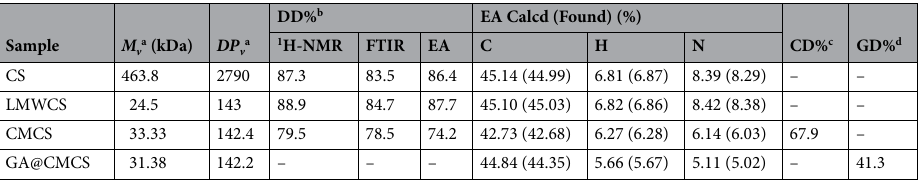
Table 1. Viscometric average molecular weights ( M v ), degree of polymerization ( DP v ), degrees of deacetylation (DD), carboxymethylation degree (CD), and grafting degree (GD) of new materials. a M v and DP v were quantified based on the values of the intrinsic viscosities of their respective solutions in 0.10 M NaCl at 25 °C (See ESM S1). b DD values were calculated from the EA and the spectroscopic data (IR and 1 H-NMR) (See ESM S1). c CD was estimated using acid–base titration (See ESM S1). d GD was estimated using Folin– Ciocalteau method 43 (See ESM S1). The GD value was 41.3% (i.e. 413 mg of GAs per 1 g of CMCS).